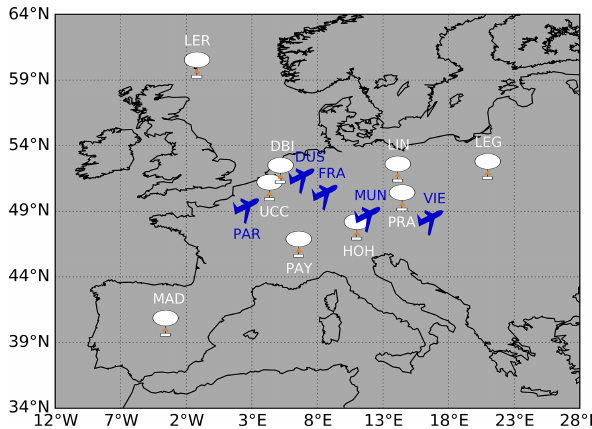
Figure 1. Location of WOUDC ozonesonde sites (white balloons) and IAGOS airports (blue airplanes) over Europe used in the present